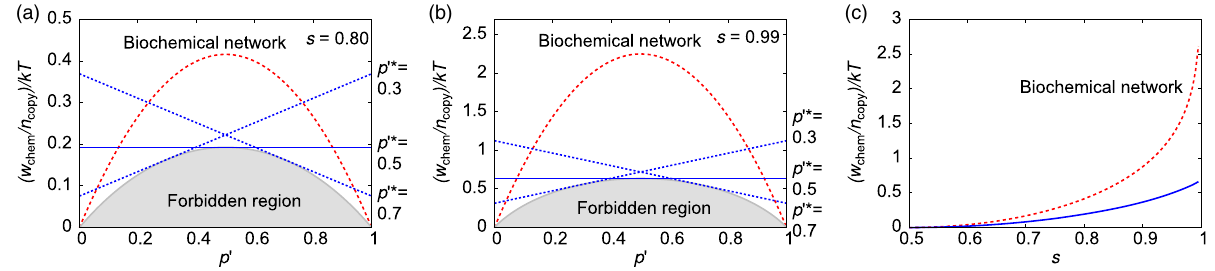
FIG. 2. Trade-off between dissipation and accuracy in copying. The (chemical) work per copy cycle for different probabilities p 0 of attempting to copy RL is plotted at two different values of the measurement accuracy: (a) s ¼ 0 . 80 and (b) s ¼ 0 . 99 . Note that p 0 ¼ p , the probability that a receptor is in state RL , if k 3 þ k 4 ¼ k 5 þ k 6 when the sampling rate for the two receptor states is the same. The biochemical implementation (red line) does not achieve the lower bound for a measuring device, which is the border of the shaded region. The blue lines correspond to quasistatic protocols for the device in Fig. 1 of the Supplemental Material (see Discussion 3 [38]) and are optimal for a specific value of p 0 , p 0(cid:2) , at the given values of s . (c) Dissipation per copy cycle at p 0 ¼ 0 . 5 as a function of s for the biochemical network (dashed red line) and a system that saturates the bound (solid blue line). The solid blue line ( p 0(cid:2) ¼ 0 . 5 ) saturates at kT ln 2 for perfect accuracy ( s ¼ 1 ), and the cost of the canonical biochemical motif